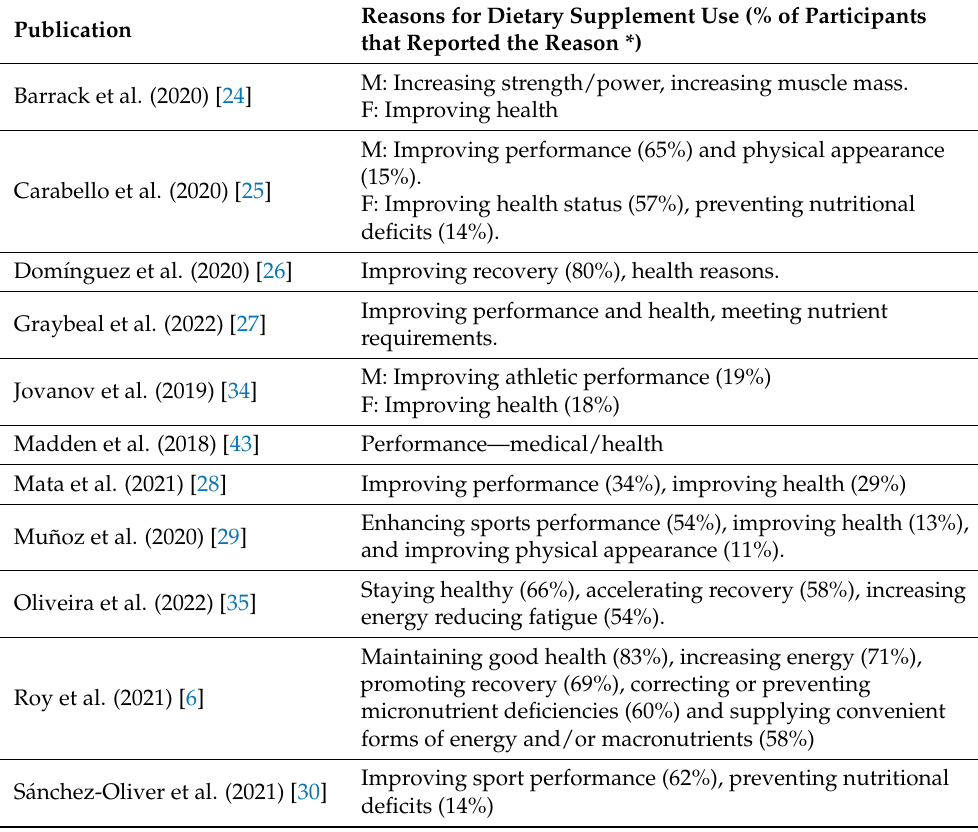
Table 2. Reasons for dietary supplement use reported by